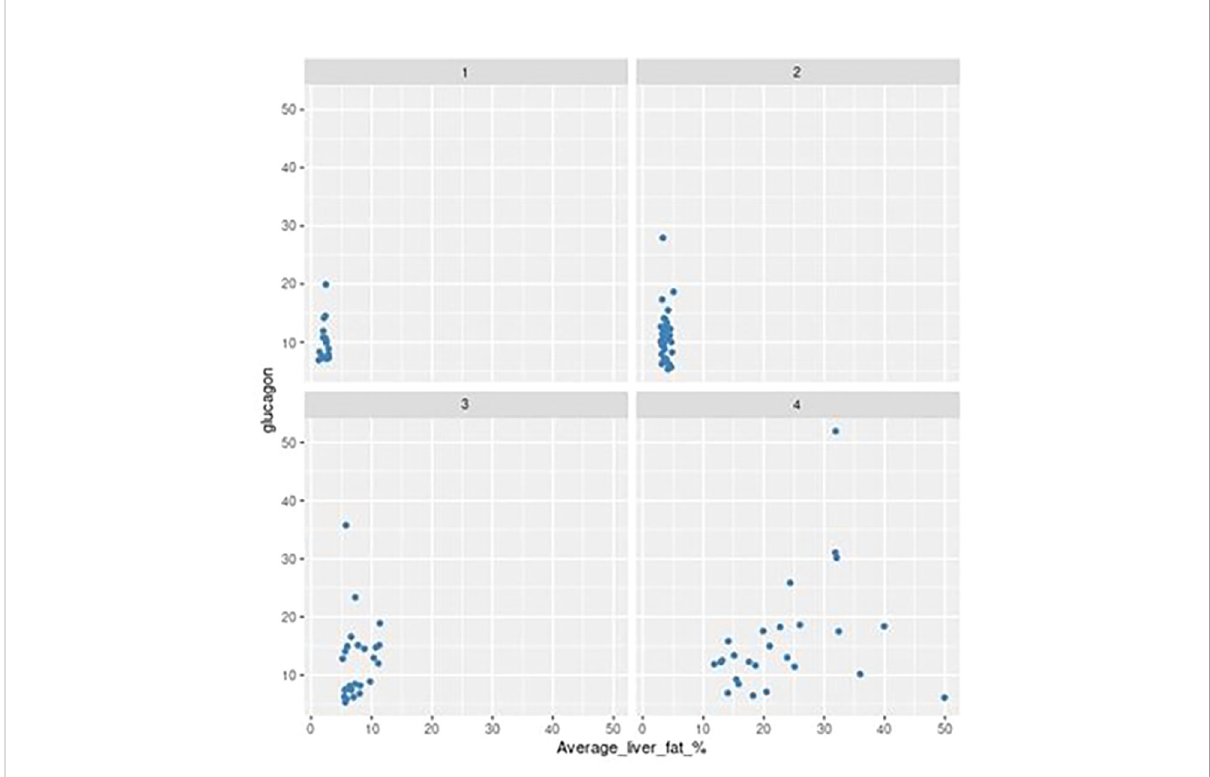
FIGURE 2 Scatter plot showing relationship between average liver fat (%) and fasting glucagon (pmol/L) grouped by MRI quartile (1-4).